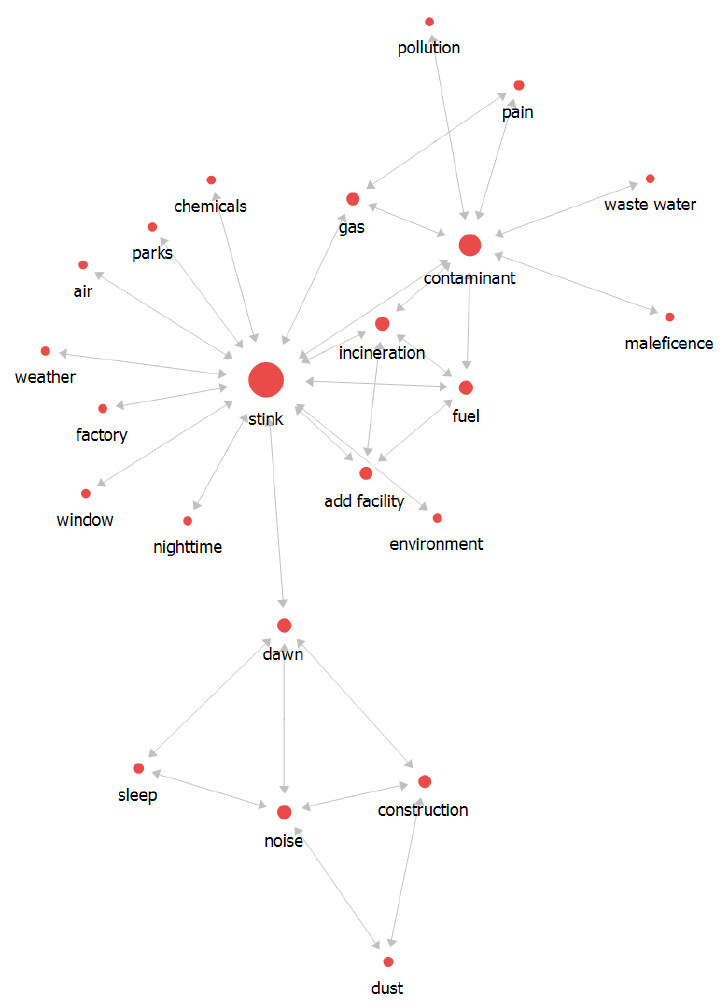
Figure 5. The relationship between words in F igure 5. The relationship between words in 2015.